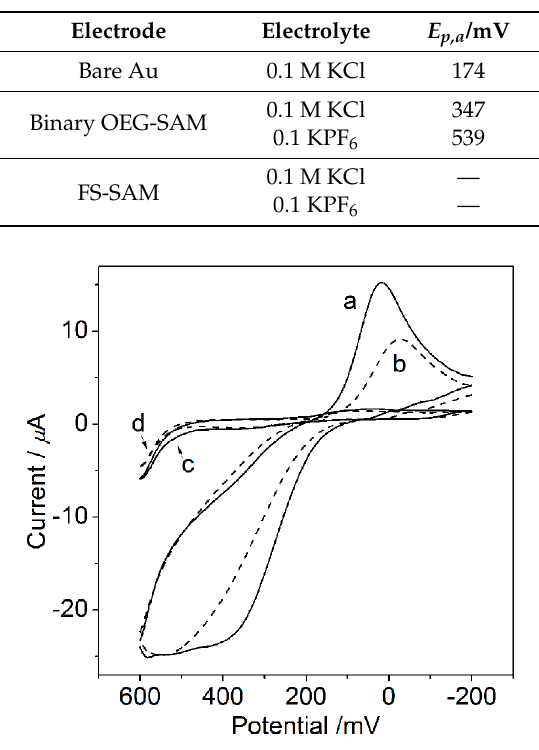
Figure 6. CV of 10 mM DA + on the binary OEG-SAM-modified gold electrodes in 0.1 M KCl (curve a ) and 0.1 M KPF 6 (curve b ), and on the FS-SAM-modified gold electrodes in 0.1 M KCl (curve c ) and 0.1 M KPF 6 (curve d ). pH: 7.0. Scan rate, 100 mV/s. pH: 7.0.